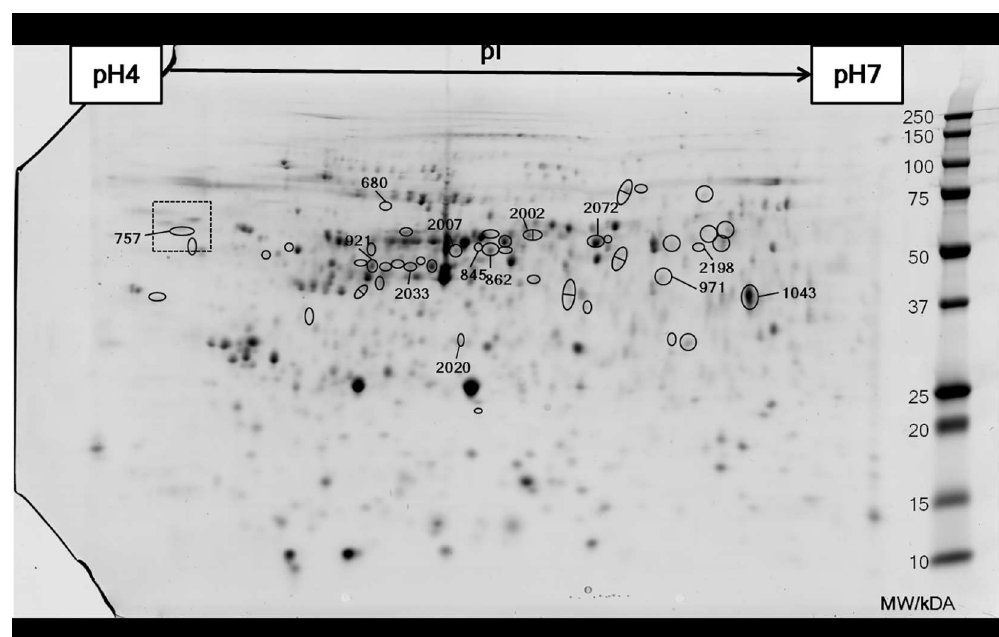
Fig 1. Representative gel of a two-dimensional SDS-PAGE of the epidermal mucus of Atlantic salmon. The first dimensionwas run on a pH4-7 IPG strip and the second dimensionwas run on an Anykd Criterion gel. Molecularweights in kDa are denotedon the right side of the image as indicatedby PrecisionPlus Dual Color protein standards (Bio-Rad).The circled spots represent those that show significantdifferentialexpressionbetween dietary treatments as given by SameSpotsanalysis(n = 6, p < 0.05).The spots that are circled and numbered refer to those that were subsequently identifiedby LC-MS/MS. The boxed area refers to Fig 2 where this part of the image has been